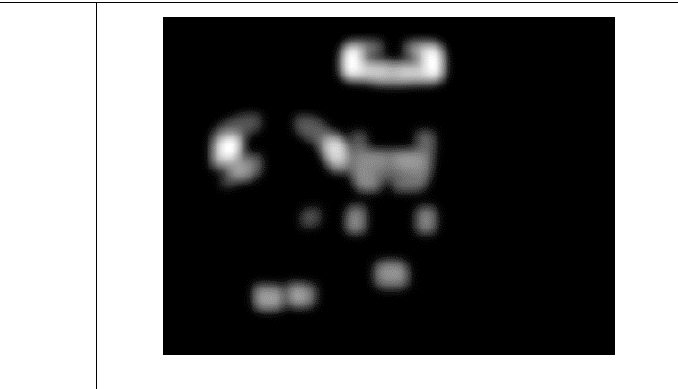
Figure 3: “Centrality map” on the 207 car image. Figure 4: Saliency map for 207-sport car image.